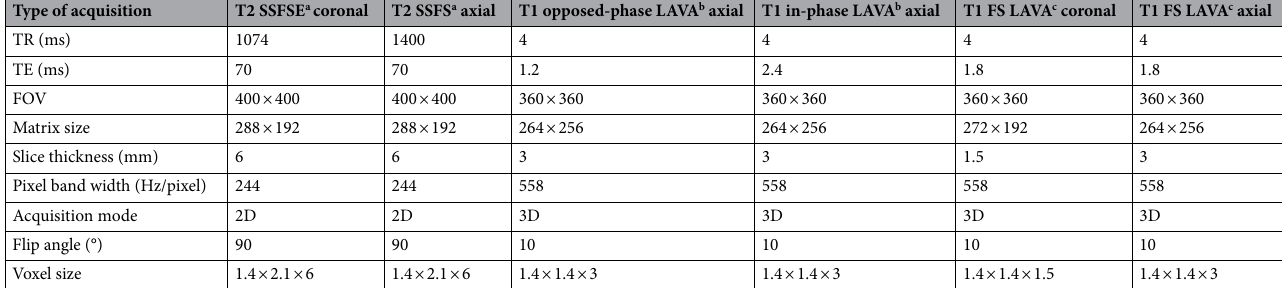
Table 3. Details of parameters used in magnetic resonance imaging sequences. FOV field of view, TE echo time, TR repetition time. a Single-shot fast spin echo sequence. b Gradient-recalled echo sequence (liver acquisition with volume acceleration sequence). c Fat-suppression gradient-recalled echo sequence (liver acquisition with volume acceleration